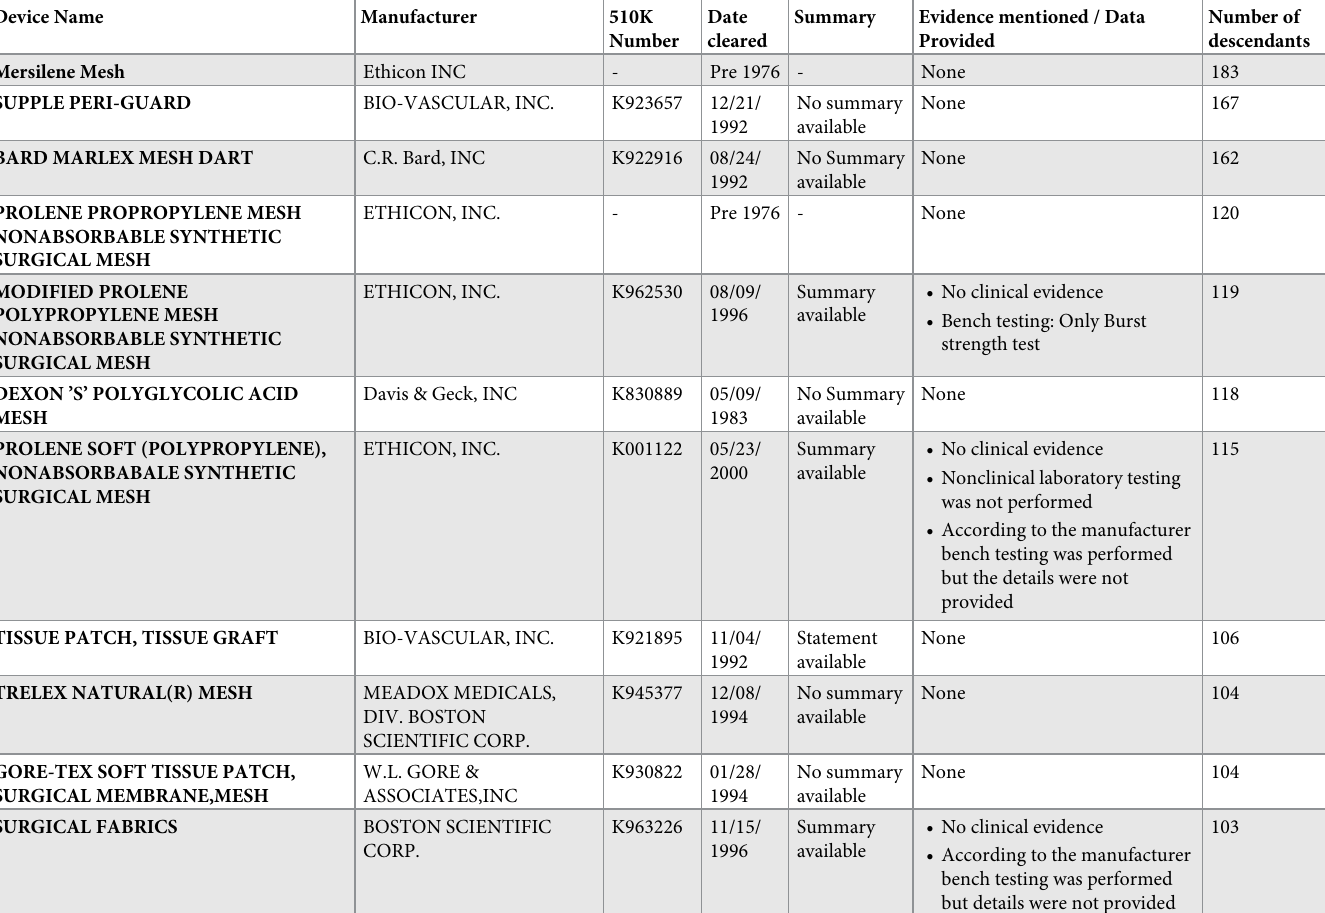
Table 1. Public availability of clinical and scientific evidence for the meshes that have led to over 100 off-spring